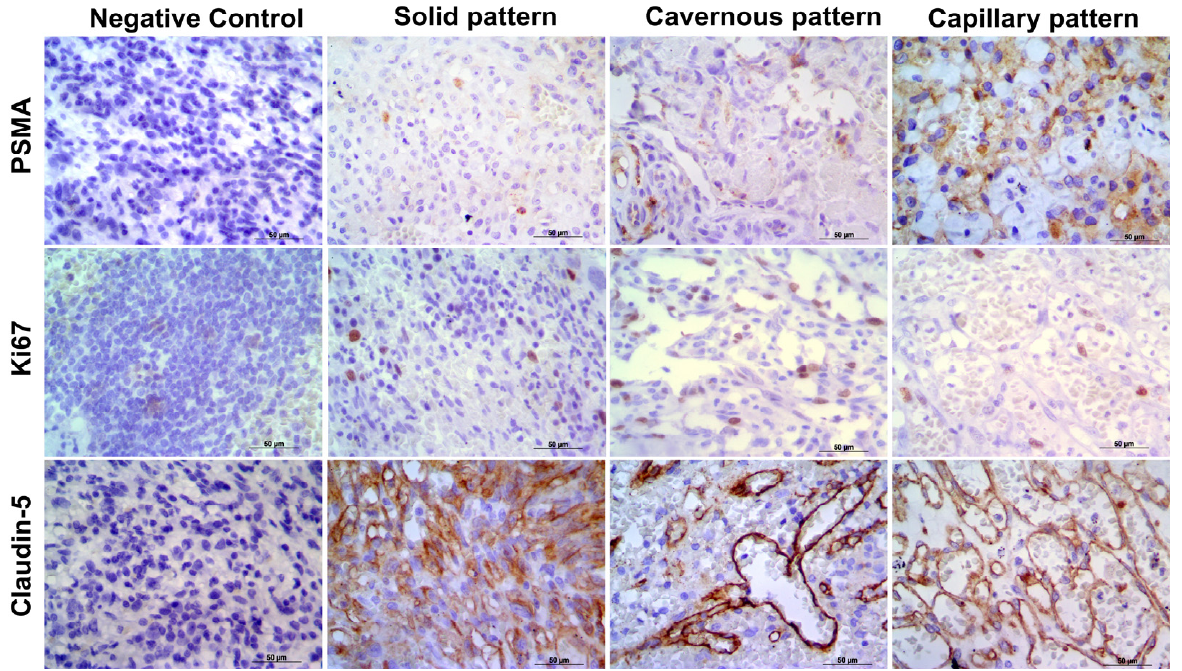
Figure 4. Representative image of each antibody in capillary, cavernous and solid patterns. It is possible to observe the negative control for each antibody and PSMA, Ki67, and Clauding-5 expression in the different histological subtypes. Harris hematoxylin counterstaining, DAB, 40.